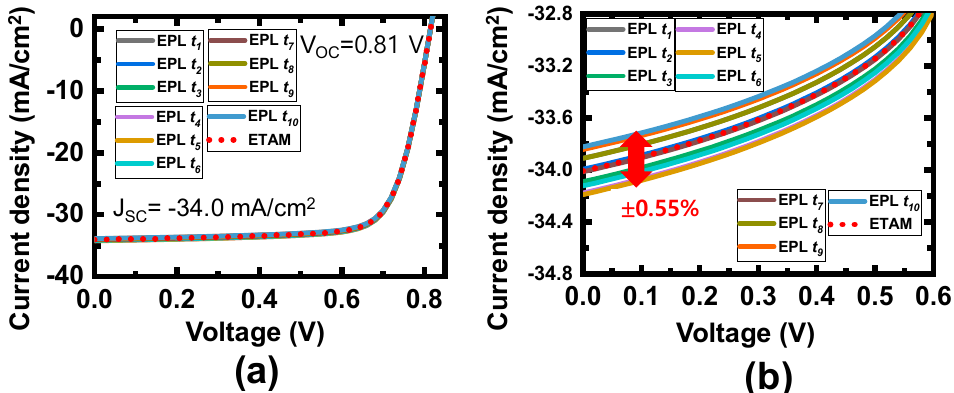
Figure 7. ( a ) Calculated J–V characteristics of a CIGS solar cell depending on the equispaced phase thickness of the EPL along with the ETAM-applied calculation result. None of the calculation results of the J–V characteristics can be distinguished due to the extremely small difference among the eleven calculation results in the J–V scale. ( b ) Close view of the J–V characteristics near the zero applied voltage. The maximal percent deviation of J SC calculated between the coherent and ETAM-applied models was ± 0.54%, the value of which can be understood to be the calculation inaccuracy when the thick cover glass layer was inappropriately modeled as the coherent layer.